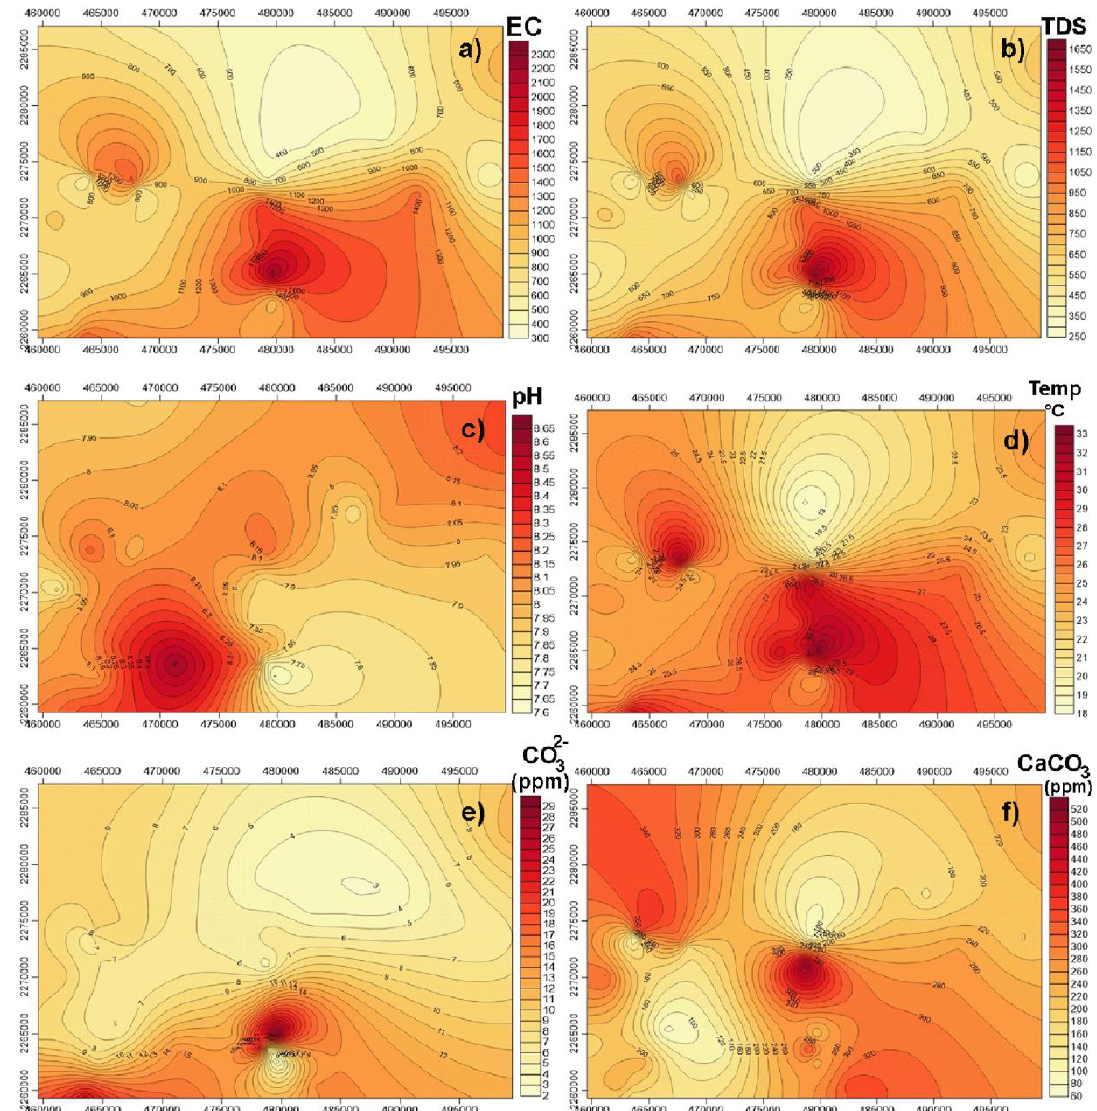
Figure 7. Spatial distribution map of ( a ) EC, ( b ) TDS, ( c ) pH, (d) temperature, ( e ) CO 32 − , and ( f ) CaCO 3 in the study area.